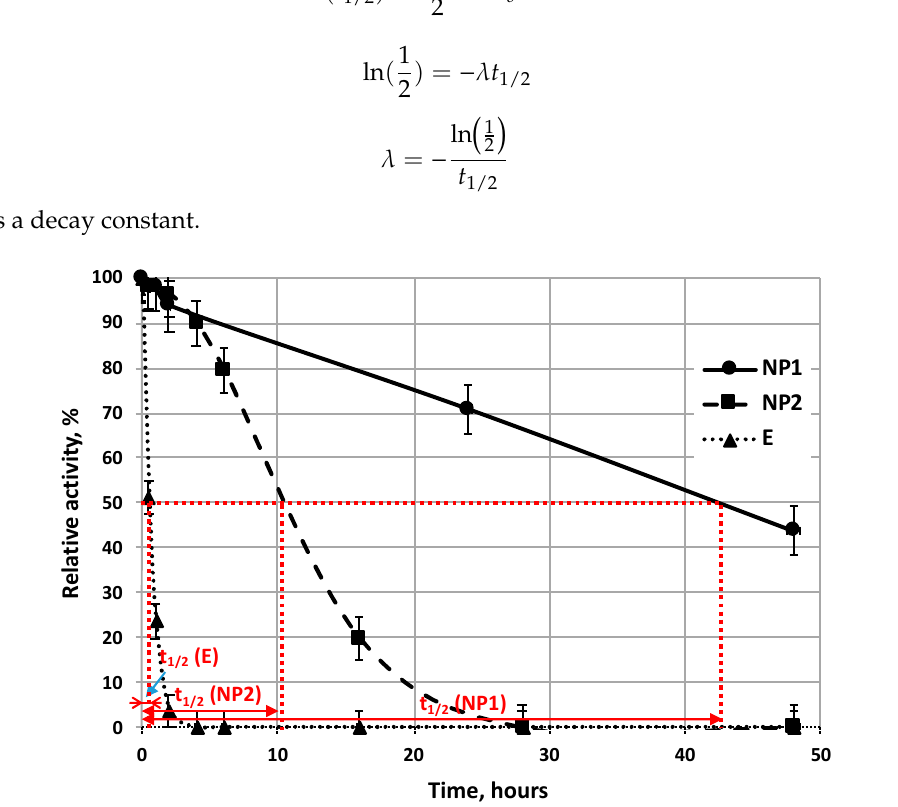
Figure 7. Activity changes of α -chymotrypsin enzyme nanoparticles covered by acrylamide-bisacrylamide random copolymer (NP2) or covered by poly(methacryloxypropyltrimethoxysilane) hybrid organic/inorganic polymer (NP1) and of free (not pretreated) enzyme (E) as a function of time measured in stirred tank reactor, with 150 rpm, at 37 °C. (Standard error values are plotted. They have varied between ±3.7% up to ±5.5%.) Table 2. Maximum reaction rate values ( v max ) and Michaelis–Menten constant ( K M ) values of